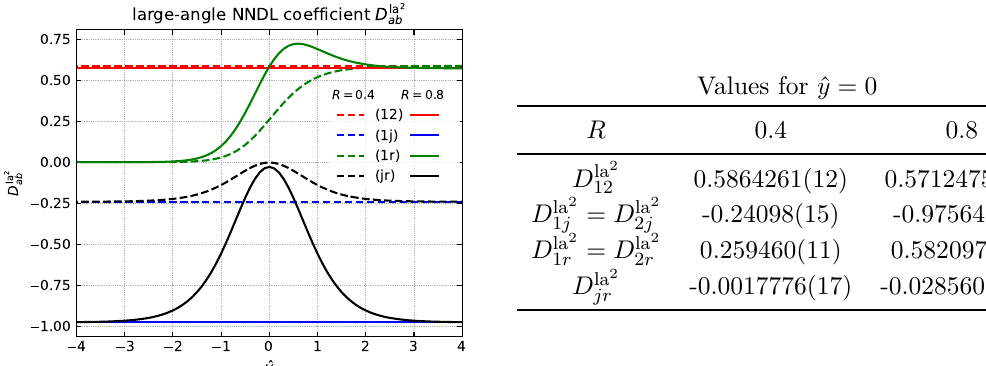
for each dipole coming from two emissions at large angles. The Figure 5 . NNDL coefficients D la 2 ab results are provided for both R = 0 . 4 and R = 0 . 8 jets. The table on the right gives numerical values for ˆ y = 0